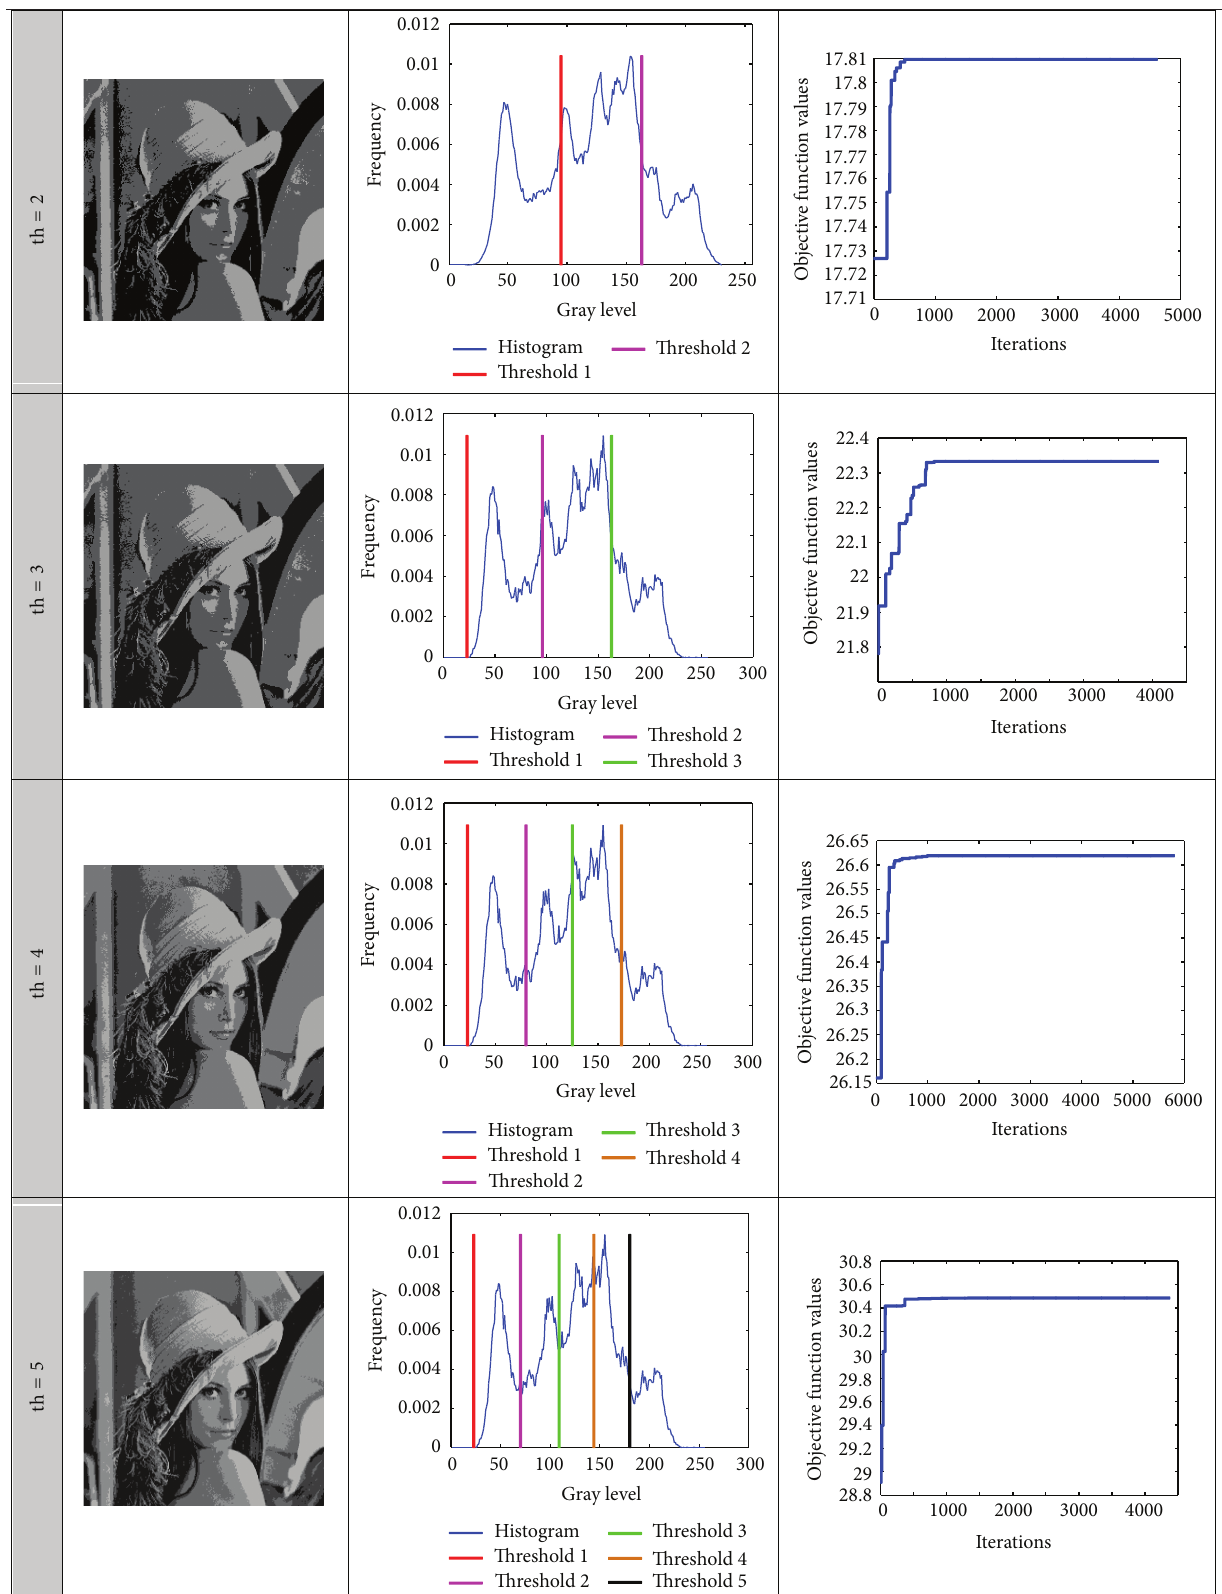
Table 11: Results after appling the HSMA using Kapur’s over Lena’s